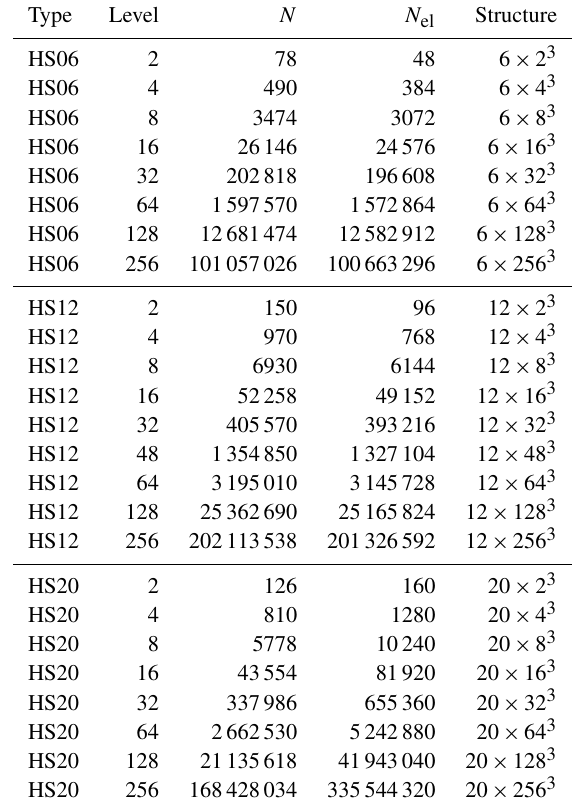
Table 1. Number of nodes ( N ) and elements/cells ( N el ) for the three types of meshes and for various levels. HS06: cubed sphere; HS12: CitcomS mesh; HS20: icosahedral